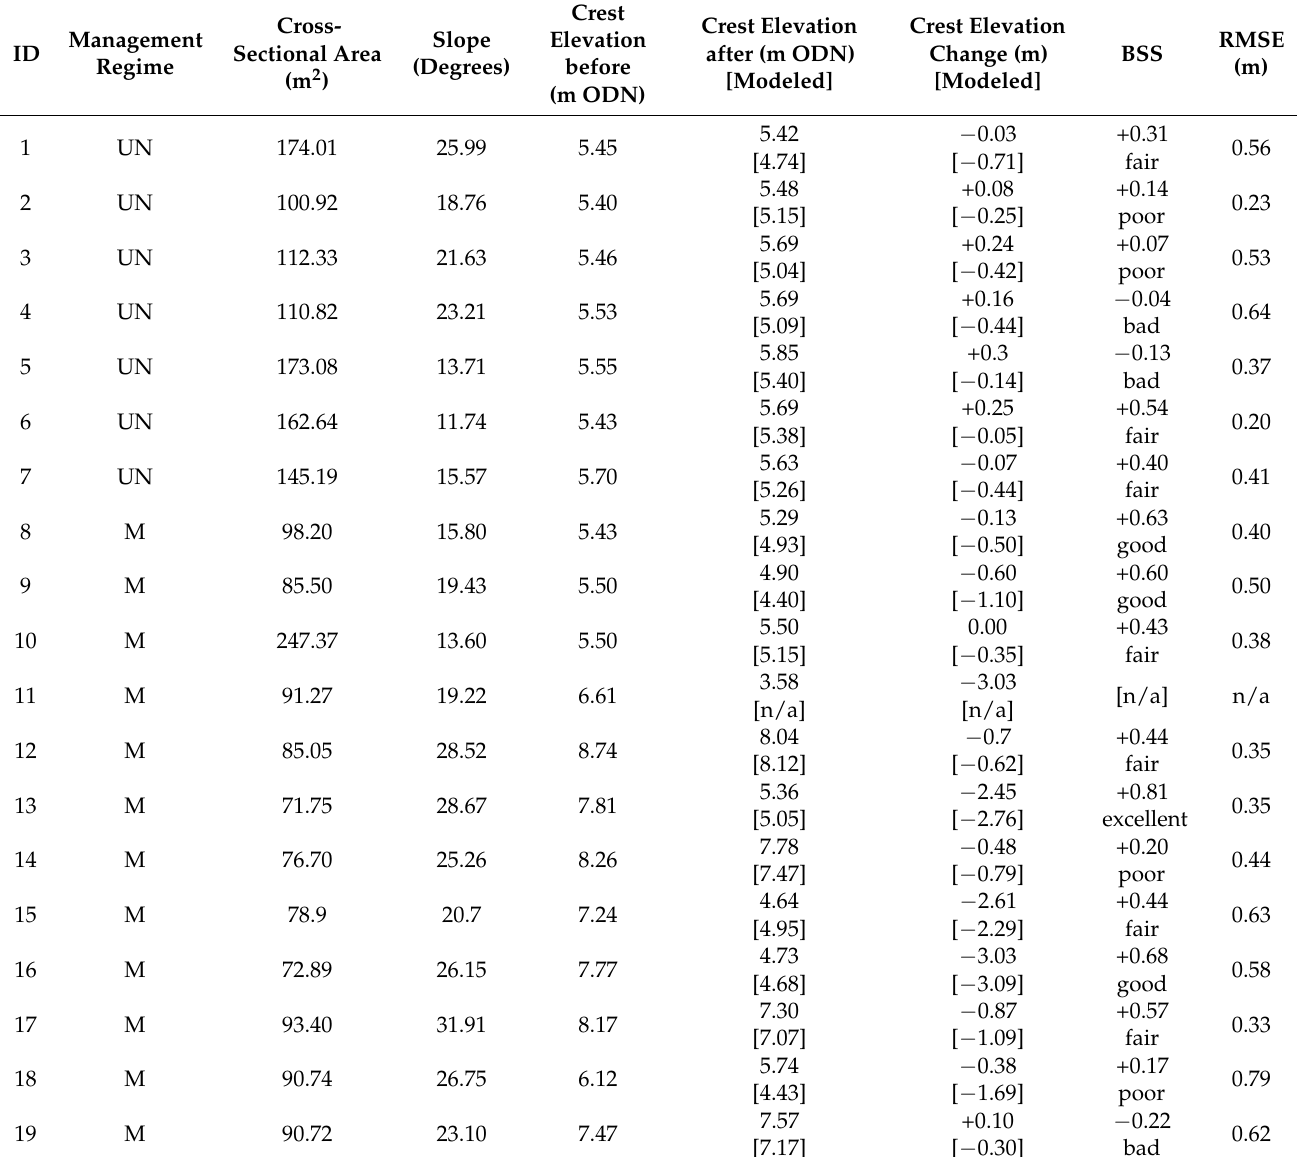
Table 3. Representative profiles used for numerical modeling along the BPBS. Barrier profiles and crest heights were measured from LiDAR available before and after the December 2013 storm surge event. XBeach-G modeled crest elevation change also reported. Barrier pre- and post-storm profiles along with XBeach-G morphological output are presented in the Supplementary Materials. Barrier cross-sectional area was calculated from the pre-storm LiDAR survey for each representative profile. Morphological observations were made using LiDAR data and vertical aerial imagery with attention to changes that have taken place since the termination of active re-profiling in winter 2005. For locations, see Figure 1c. ODN, Ordnance Datum